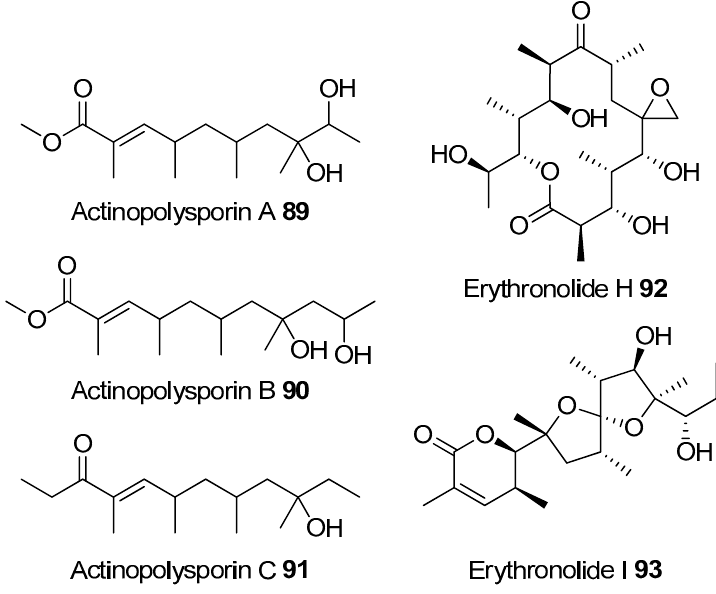
Figure 22. Polyketides identified from Actinopolyspora erythraea .